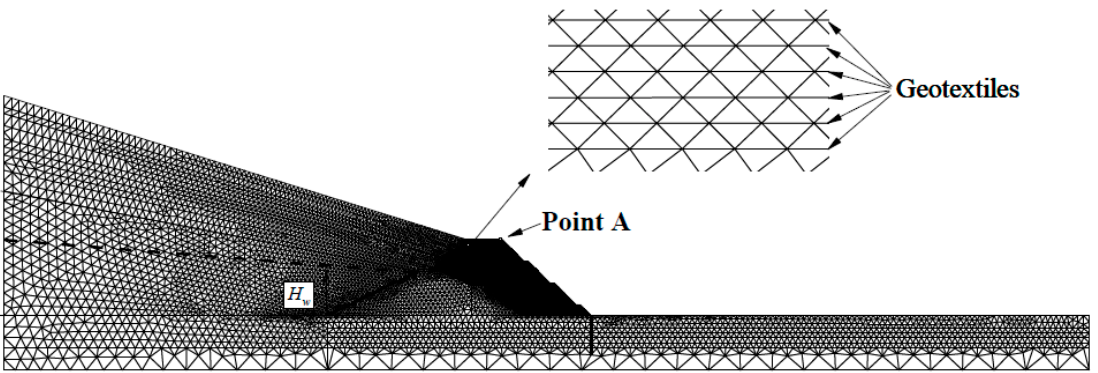
Figure 3. Finite element mesh.